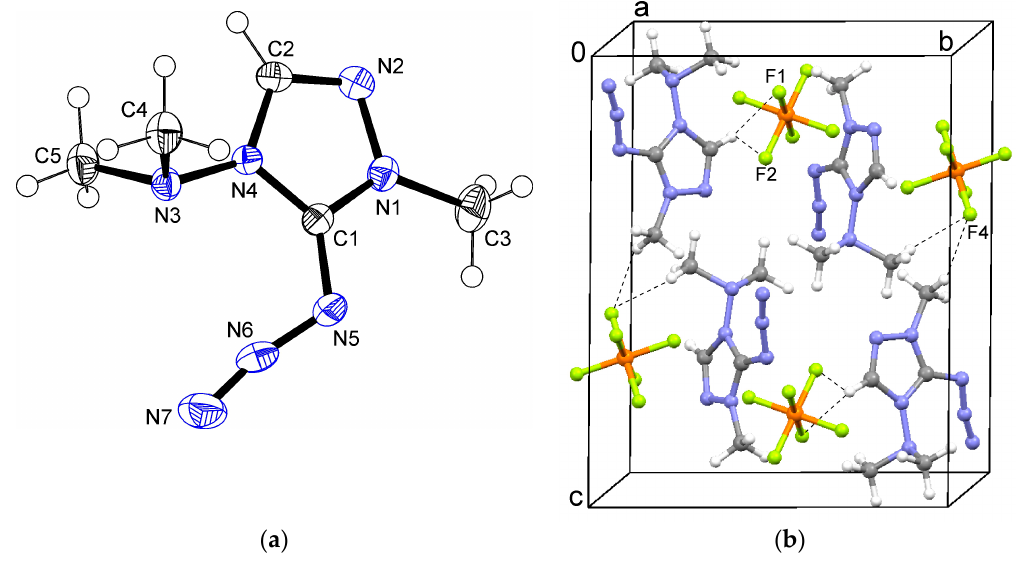
Figure 2. ( a ) O RTEP plot of the cation in 1 ; and ( b ) packing in the crystal structure of 1